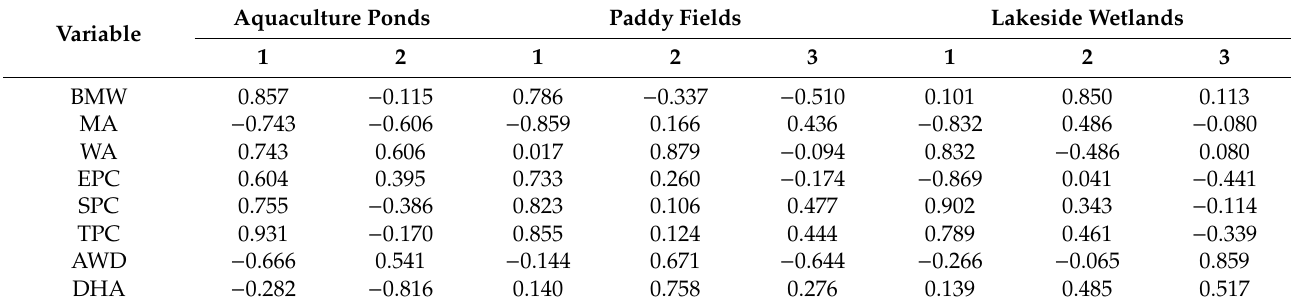
Table 6. Principal components of habitat factors in di ff erent